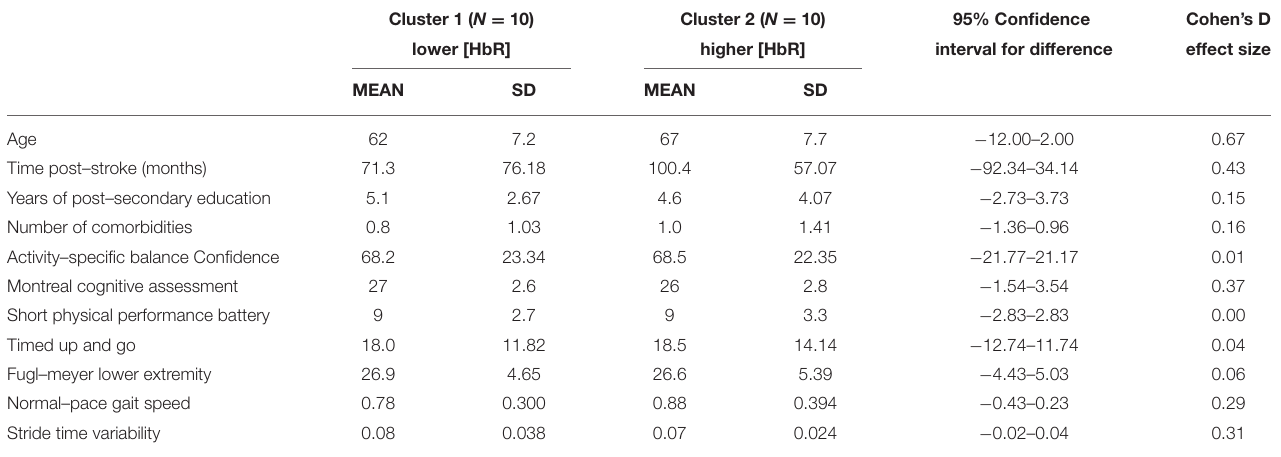
TABLE 5 | Demographic and clinical outcome averages split between HbR